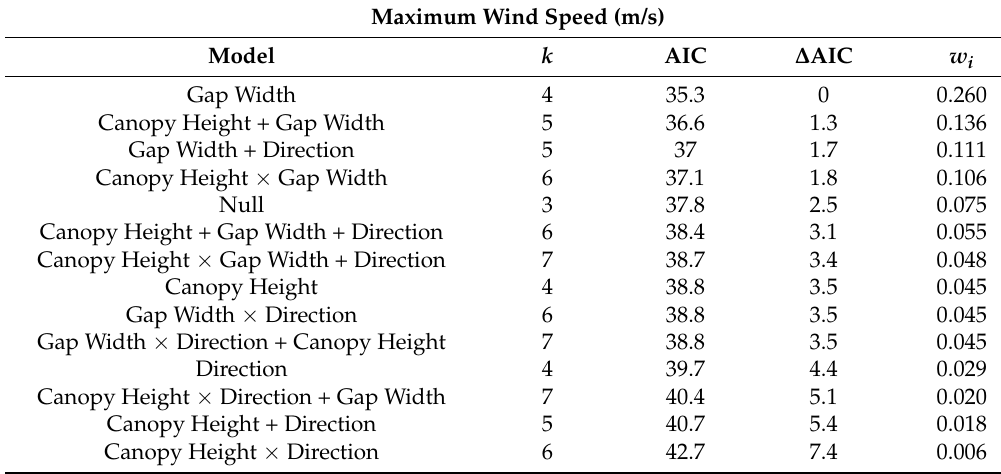
Table A3. Generalized Linear Mixed Models for maximum wind speed along seismic lines. All possible combinations of canopy height, gap width, and direction were modeled, with models more supported than the null model shown. Results are showing in ascending order of AIC weight. Number of parameters ( k ), delta AIC, and likelihood of the model based on Akaike weights ( w i ) are